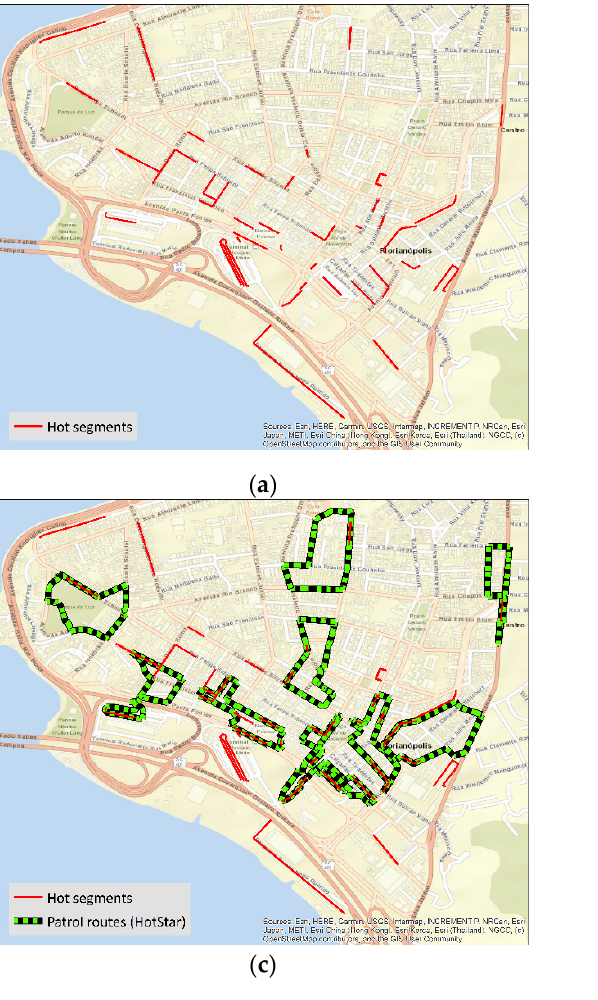
Figure 4. ( a ) Hot segments in downtown Florianópolis shown with ( b ) patrol routes created manually, ( c ) patrol routes created using HotStar and ( d ) patrol routes created using HotSee.